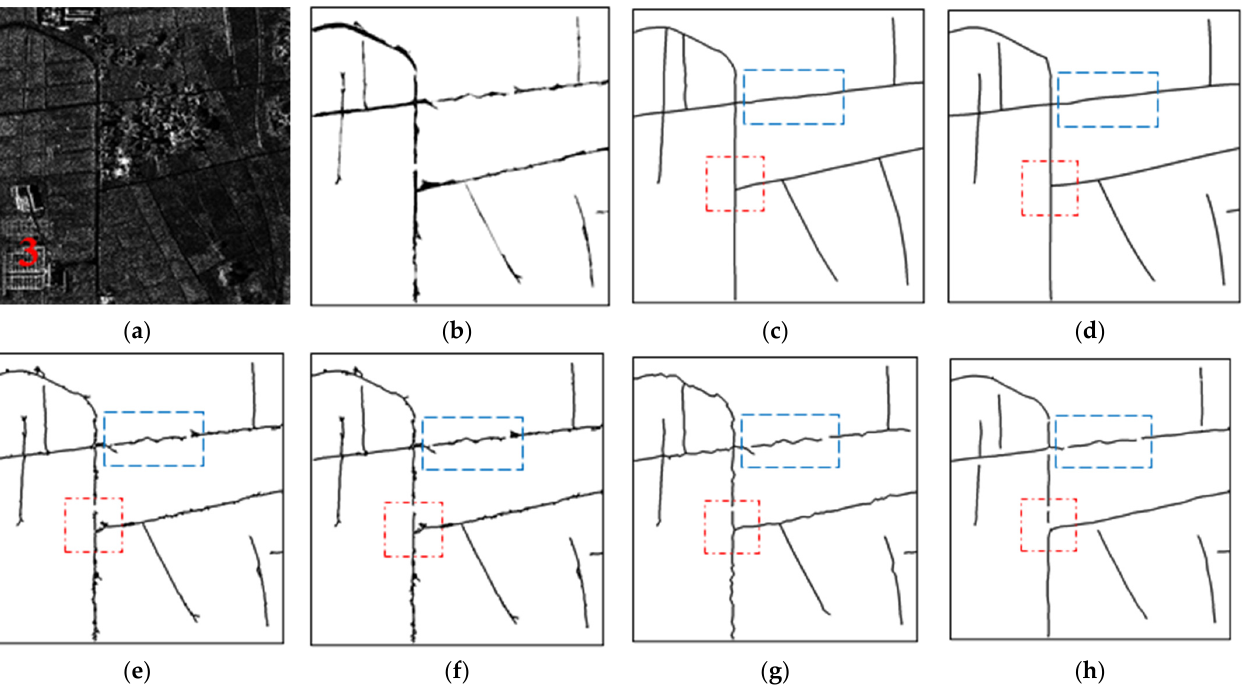
Figure 11. Experimental results for test image 3. ( a ) Original SAR image. ( b ) Segmented road map. ( c ) Reference centerline map. ( d ) Result of the proposed method. ( e ) Result of the MT method. ( f ) Result of the ZST method. ( g ) Result of the MARS method. ( h ) Result of the NMS method.